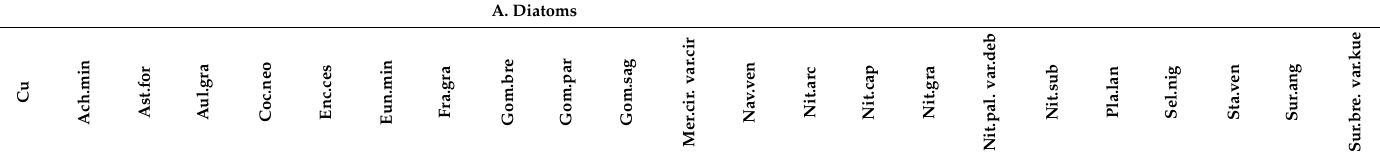
Table 8. Spearman’s rank order correlation for diatoms (A) and cladocerans (B) from sediment core of subsidence pond formed during the peak of ore